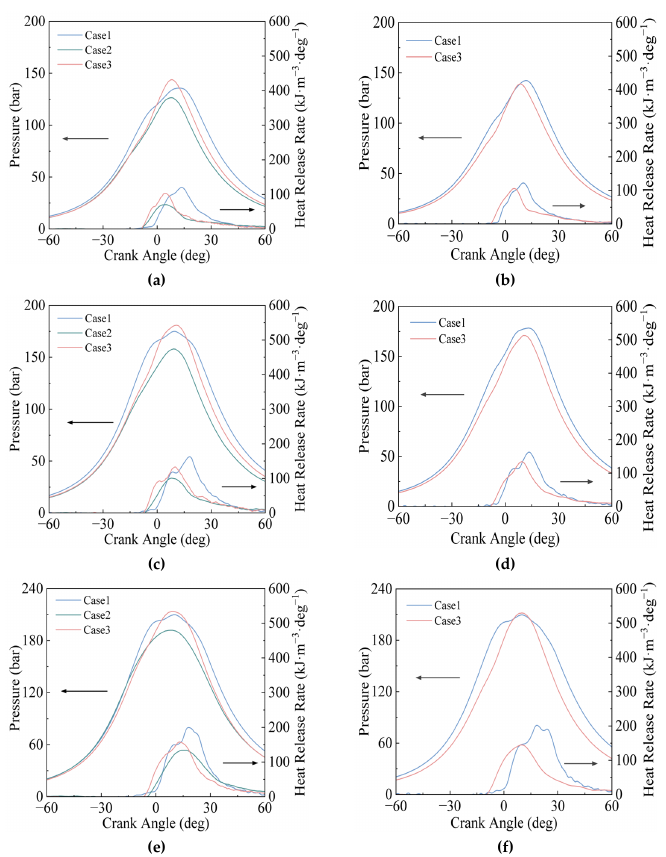
Figure 3. Combustion characteristics for variable EBP at different loads. ( a ) EBP = 10 kPa, load = 50%; ( b ) EBP = 25 kPa, load = 50%; ( c ) EBP = 10 kPa, load = 75%; ( d ) EBP = 25 kPa, load = 75%; ( e ) EBP = 10 kPa, load = 100%; ( f ) EBP = 25 kPa, load = 100%.